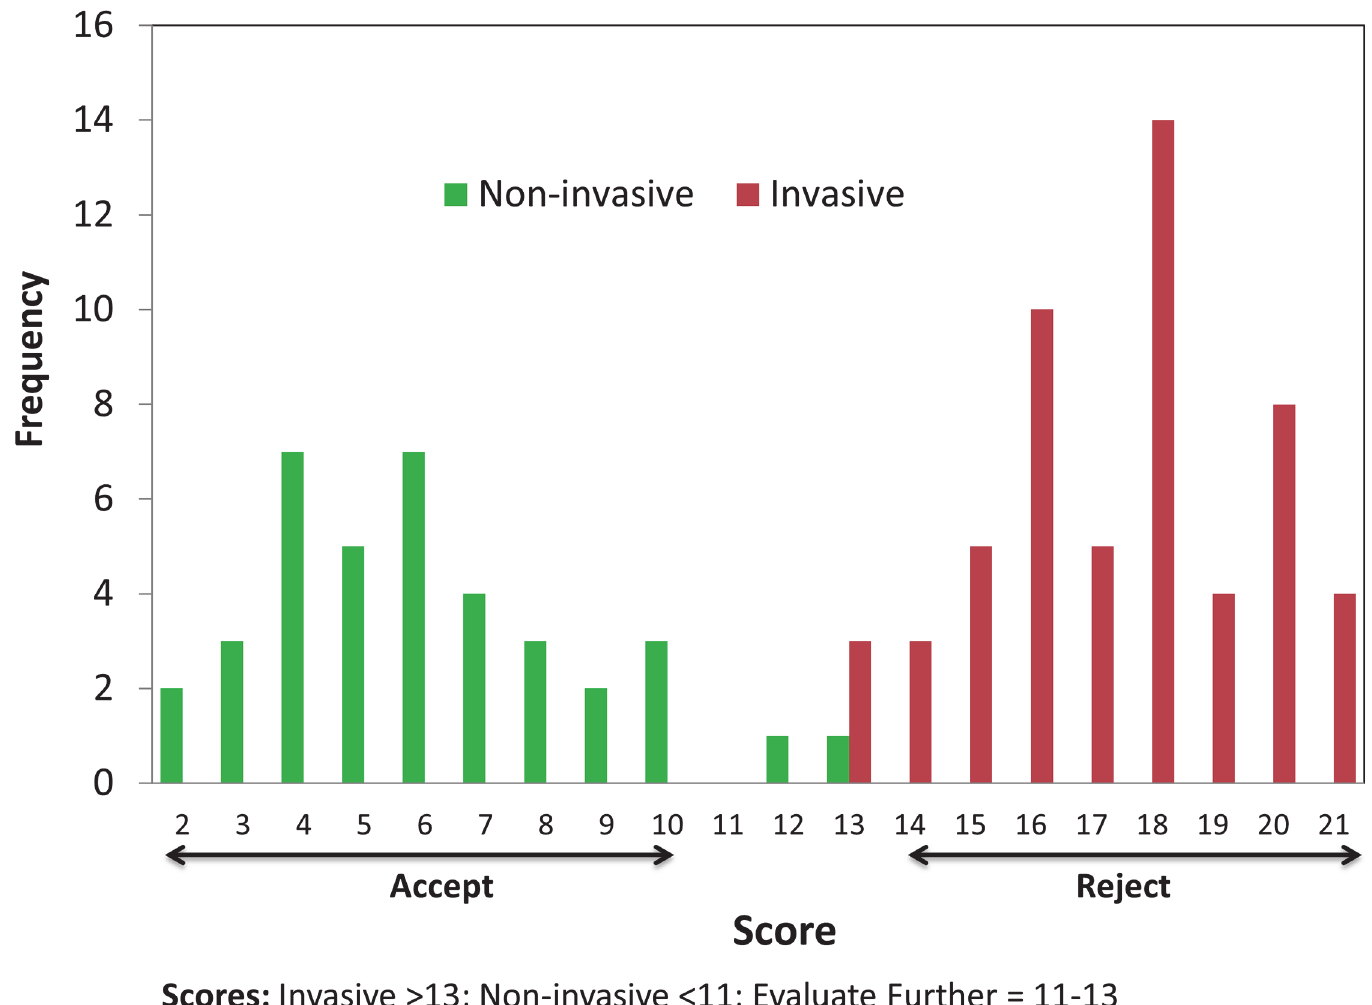
Fig 1. Histogram of scoring frequencies for the 19-question PlantRight plant risk evaluation (PRE) tool.